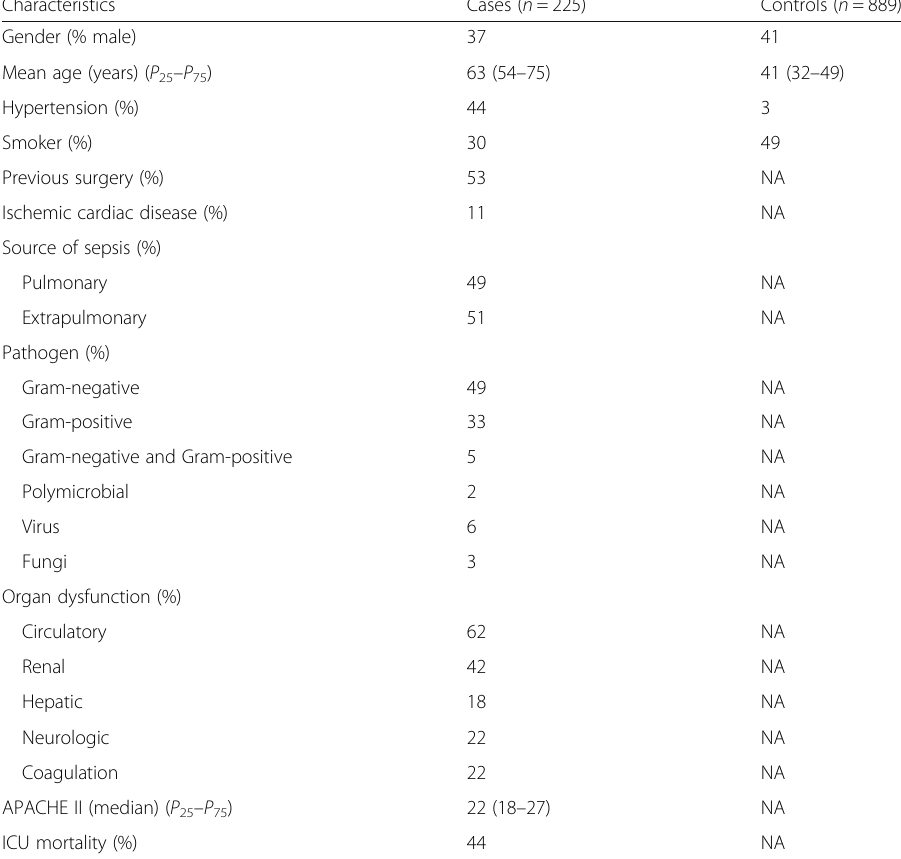
Table 1 Characteristics of ARDS patients and controls of the discovery study